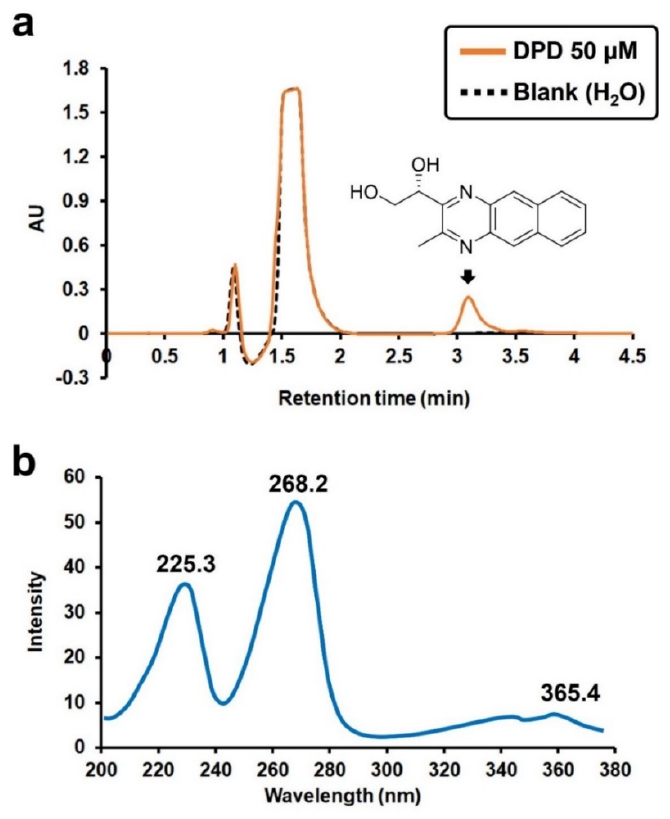
Figure 2. ( a ) HPLC chromatogram of the reaction mixture of DPD and DAN with a UV detector at 225 nm, and ( b ) UV spectrum for the AI-2 derivative.